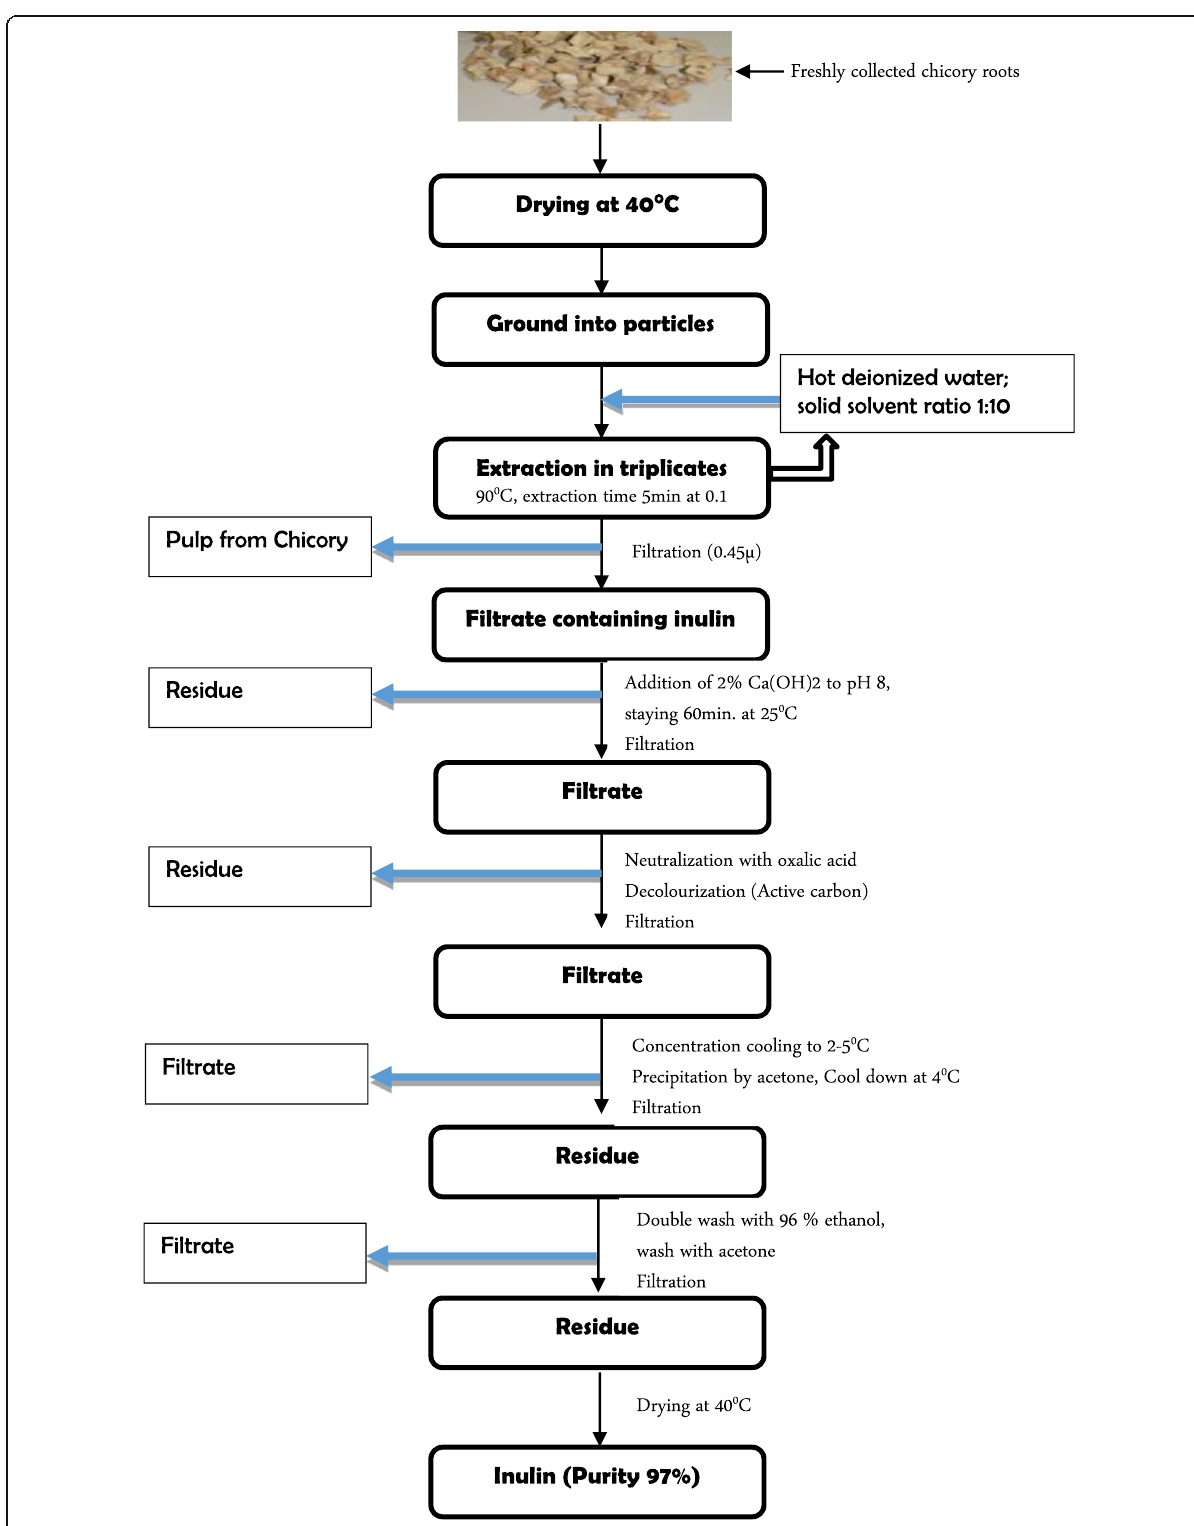
Fig. 1 Schematic inulin extraction process from